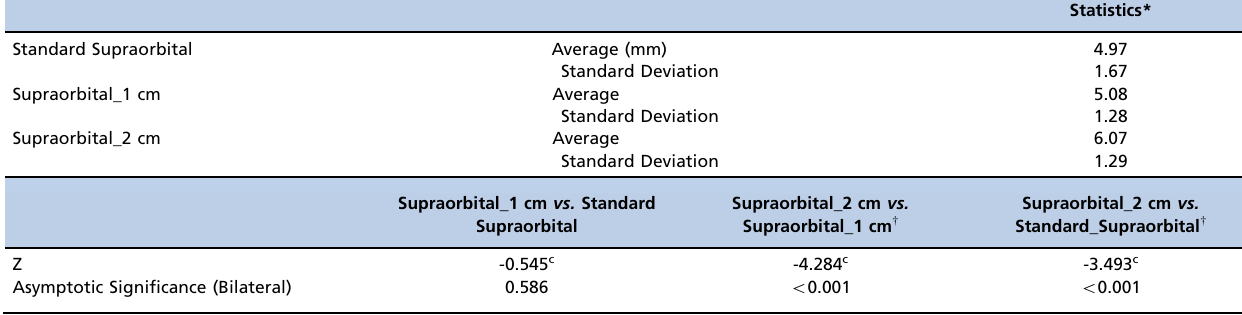
Table 4 - Supraorbital pin comparison between children 12 and 17 years of